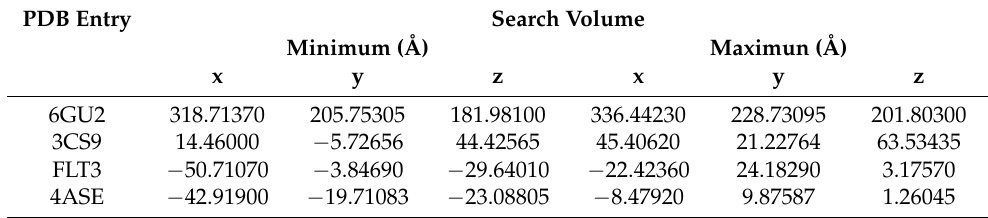
Table 3. Search volume for molecular